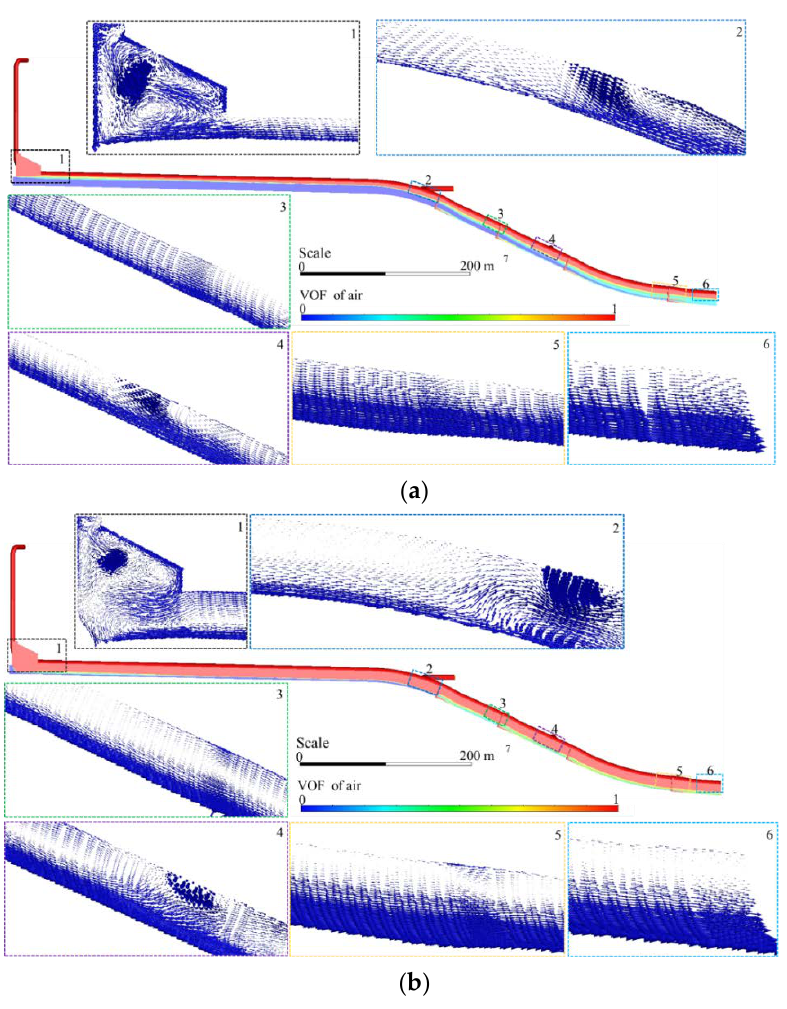
Figure 13. Vectors of air velocity in the free space above water in the tunnel. ( a ) 100% gate opening ratio, ( b ) 25% gate opening ratio.